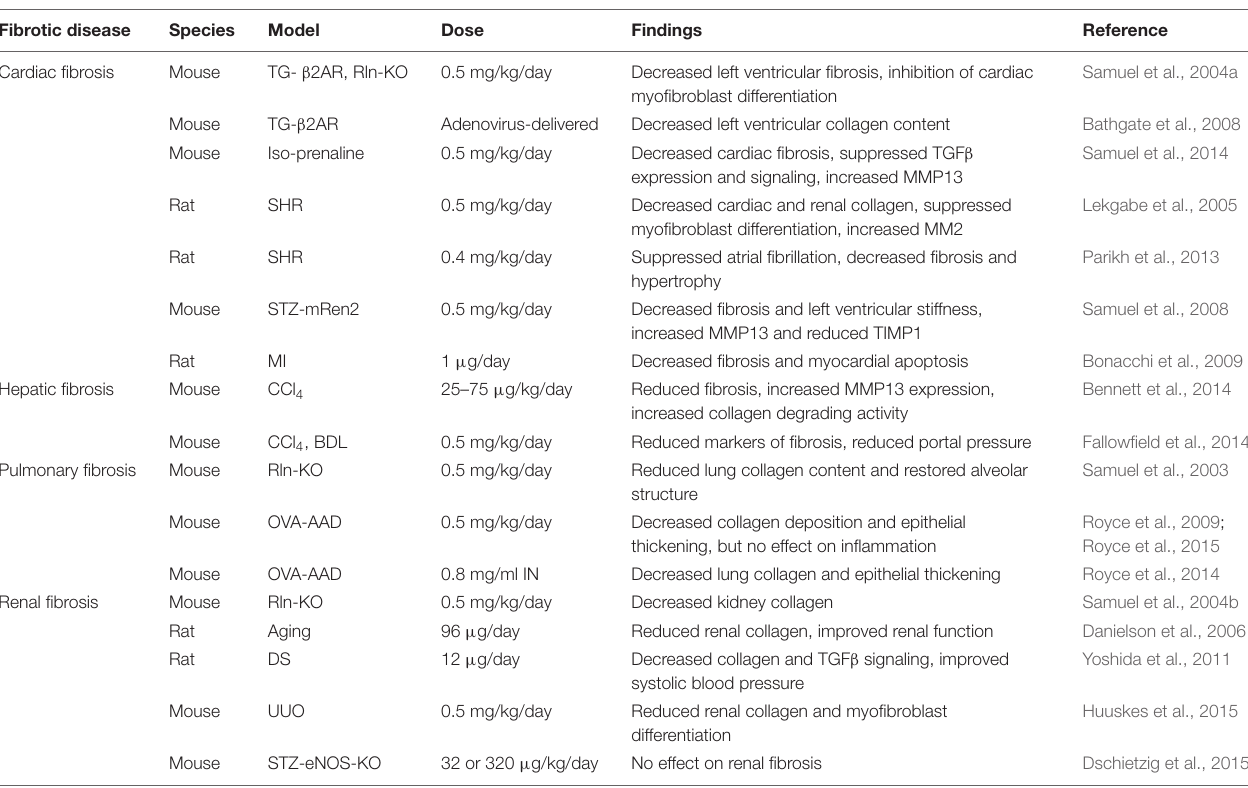
TABLE 4 | Selected preclinical studies using relaxin for established fibrosis. Preclinical studies in animal models with established